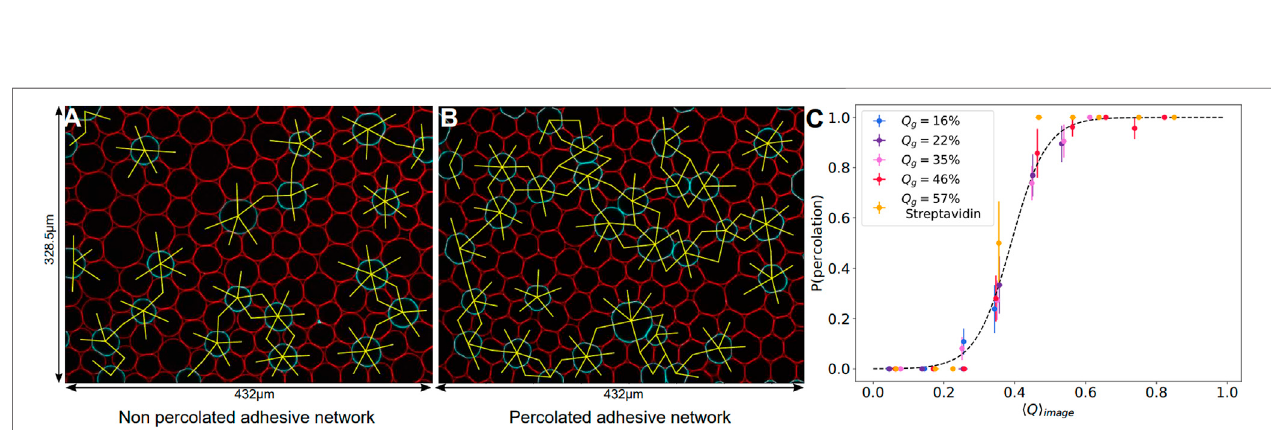
FIGURE7| Adhesive contact percolation — (A, B) Exampleimages ofadhesive networks for DNA droplets, withconnectionsbetweenadhesive droplets in yellow. If there is no continuous path between opposite borders, the network is non percolated (A) , if a path exists, the network is percolated (B) . Image sizes: 432 μ m × 328.5 μ m. (C) Probability of percolation in networks of adhesive droplets. The probability of forming a continuous adhesive path between two opposite bordersofeachimageisplottedagainstthemeanadhesiveness 〈 Q 〉 image calculatedinthecorrespondingimage.Allexperimentalconditionscollapseonthesame curve and can be fi tted by a sigmoid of equation [ 1 + e − 20 ( x − 0 . 39 )]− 1 (black dashed line).